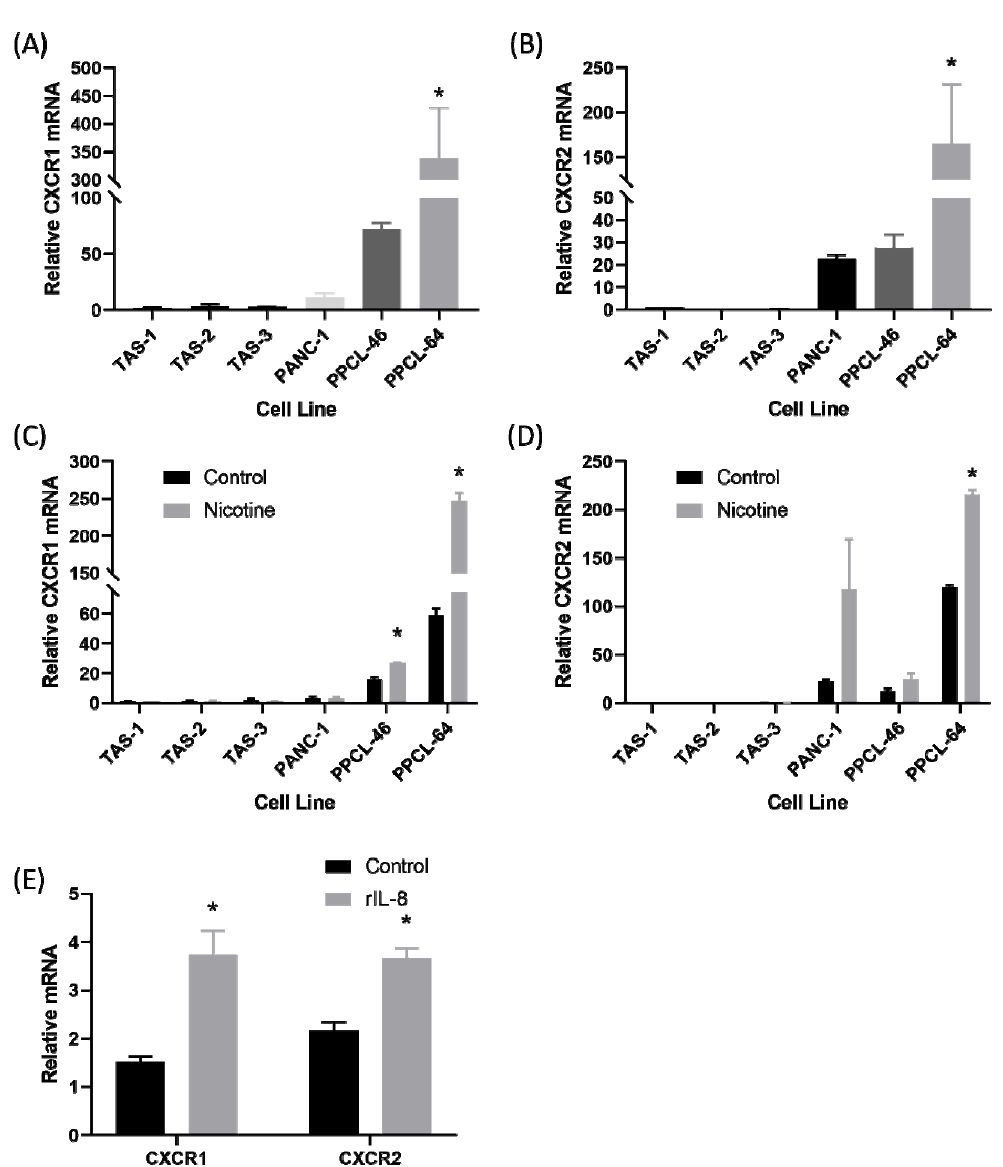
Figure 3. The IL-8 receptor was upregulated on pancreatic cancer cells lines in response to nicotine treatment and recombinant IL-8 (rIL-8) treatment. ( A ) Expression of the C-X-C motif chemokine receptor-1 (CXCR1) receptor, measured by qRT-PCR, was significantly elevated in patient-derived primary pancreatic cancer cell line (PPCL-64) compared to PPCL-46, PANC-1, and patient-derived tumor-associated stromal cell lines. ( B ) Similarly, expression of the C-X-C motif chemokine receptor-2 (CXCR2) receptor was significantly elevated in PPCL-64 compared to the other cell lines. ( C ) Nicotine treatment significantly increased CXCR1 expression in PPCL-64 and PPCL-46, but not PANC-1 or TAS cells. ( D ) Expression of the CXCR2 receptor was significantly elevated in PPCL-64 cells treated with nicotine compared to other cells lines. ( E ) Treatment of PPCL-46 with 1.25 nM recombinant IL-8 for 24 h resulted in a significant increase in CXCR1 and CXCR2 messenger RNA (mRNA).